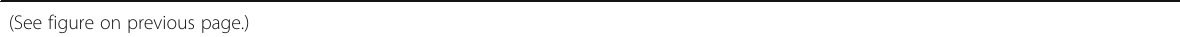
(See figure on previous page.) Fig. 2 Pedigree of the investigated family and its NGS results of DMD. a Genealogical tree of the DMD family. Proband, male DMD